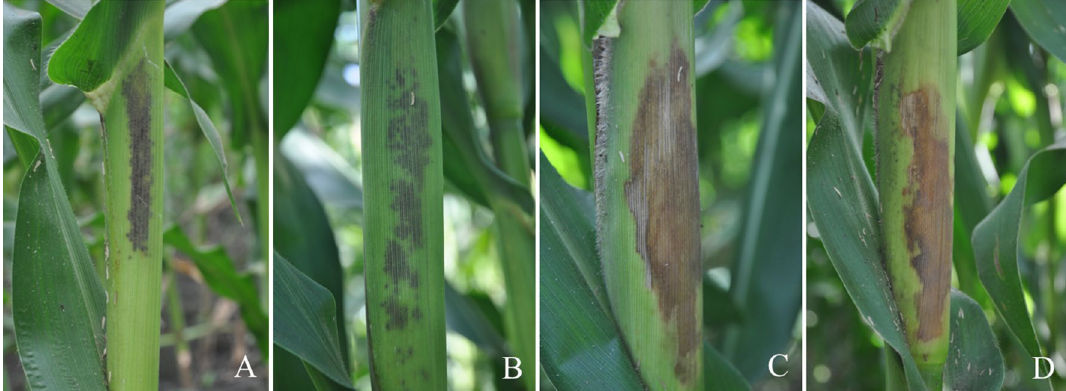
Figure 1. Disease symptoms of corn Fusarium sheath rot in the field were divided into two types of symptoms: small black spots with a linear distribution ( A , B ) and wet blotches with a tawny or brown color ( C , D ).